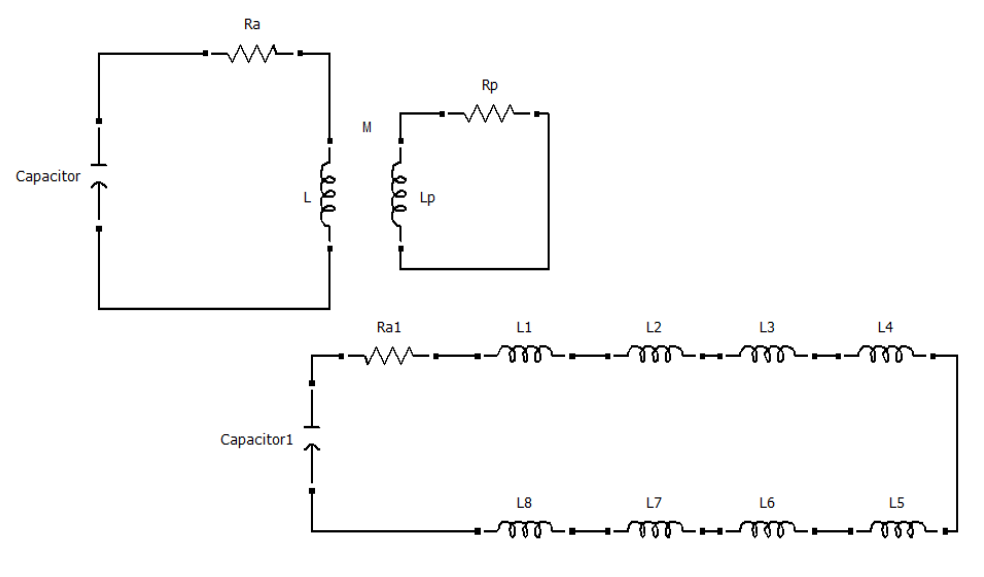
Figure 7. Electrical Equivalent circuit of